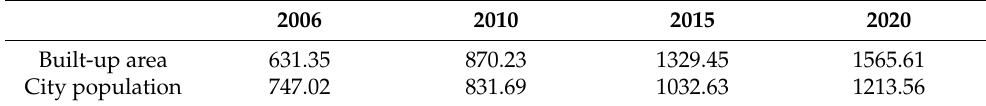
Table 10. Built-up Area and Urban Population in Chongqing,